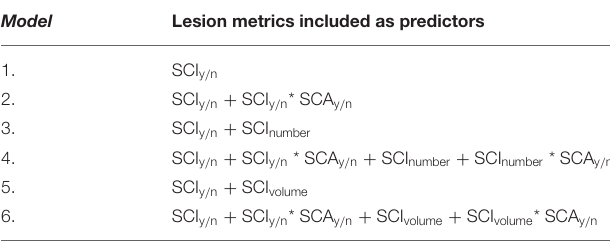
TABLE 1 | Representation of lesion metrics included in regression models.